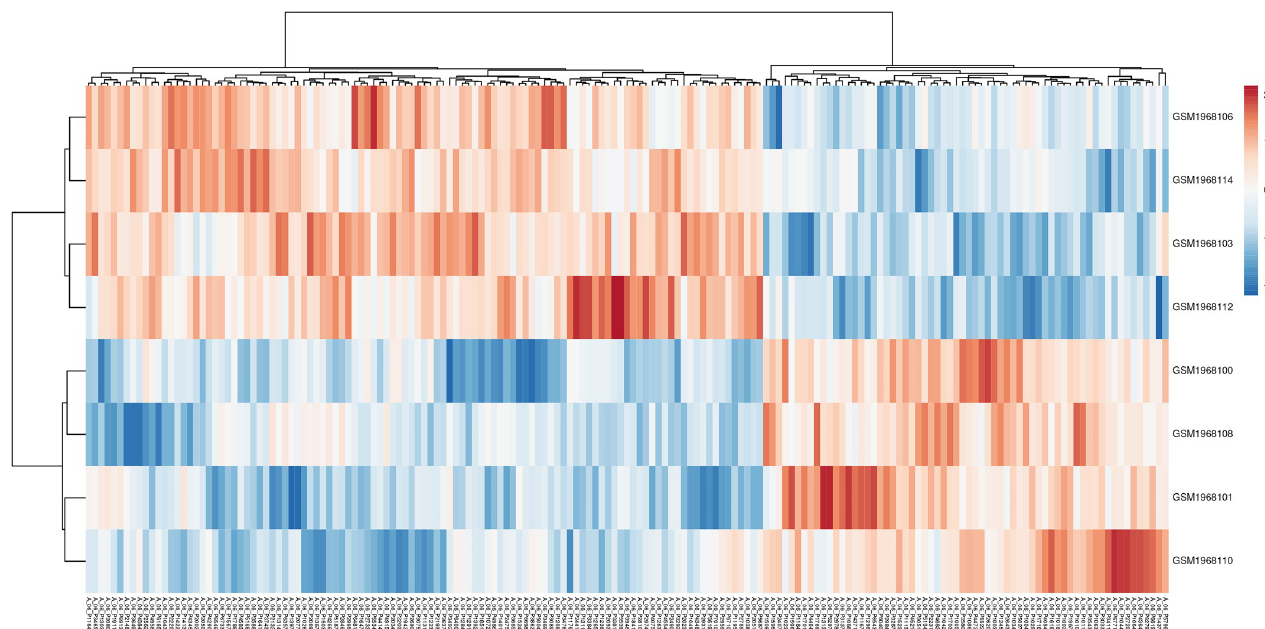
Fig 2. The heatmap related to 171 probe sets which were recognized by at least 5 attribute weighting algorithms (AWAs). Each row corresponds to the different samples including Mg 2+ (high ethanol production) and Cu 2+ supplementation (repressed ethanol production). Columns exhibits hierarchically clustered probe sets. The normalized intensity expressions of probe sets were shown as a color scale. The up and down-expression levels were represented as red and blue scales,